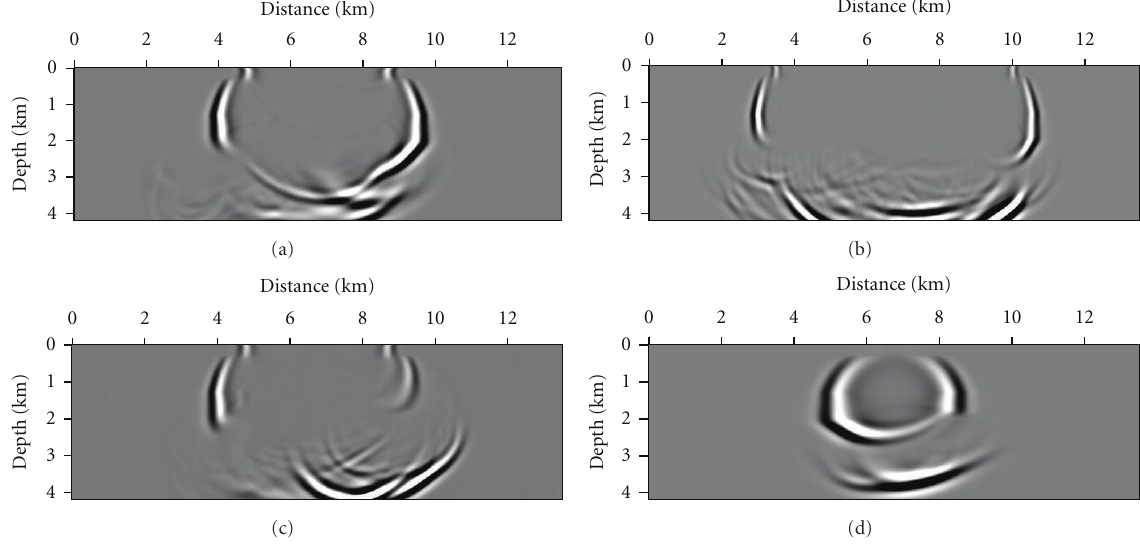
Figure 7: Impulse response of FFD migration with alternating four-way splitting. Vertical cuts as in Figure